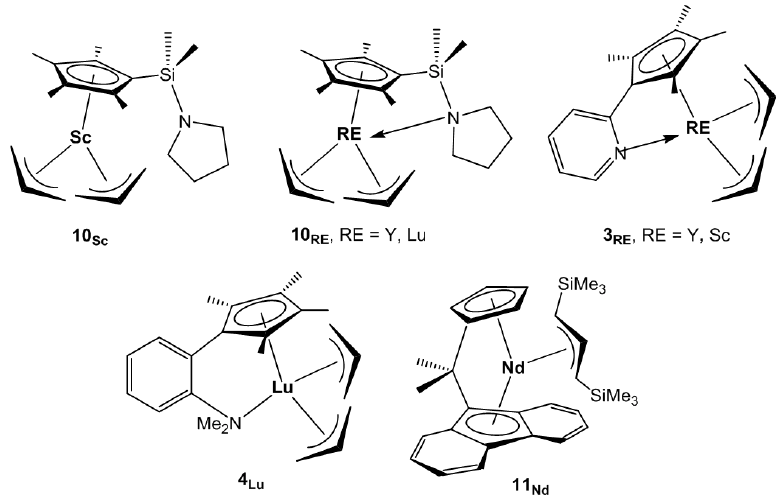
Scheme 6. Allylic rare earth complexes used for styrene polymerization